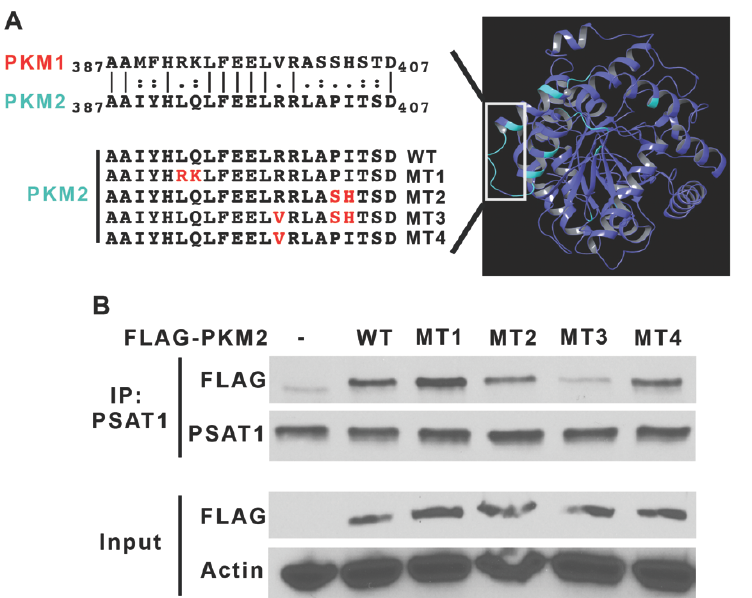
Figure 2. Mutations within an isoform-specific region of PKM2 weakens the PSAT1 interaction. ( A ) Schematic representation of PKM2-specific mutations generated for the analysis of the PSAT1– PKM2 association. Ribbon representation of the structure of PKM2 colored by PKM1 sequence homology (right panel). Identical regions are shown in purple and divergent regions in cyan. The left panel depicts the site-directed mutagenesis of amino acids (MT1–4, highlighted in red) in the PKM2-specific region (denoted in the white box). ( B ) FLAG-PKM2 wild-type (WT), mutants (MT1–4) and FLAG-EV (-) were expressed in HEK293T cells. Endogenous PSAT1 protein complexes were immunoprecipitated and the association with PKM2 was assessed by immunoblot. A similar expression of FLAG-PKM2 variants is shown by immunoblot of FLAG fusion proteins from the protein lysate input with β -actin used for a protein loading control. Shown are representative images from three separate experiments. (-) denotes an empty